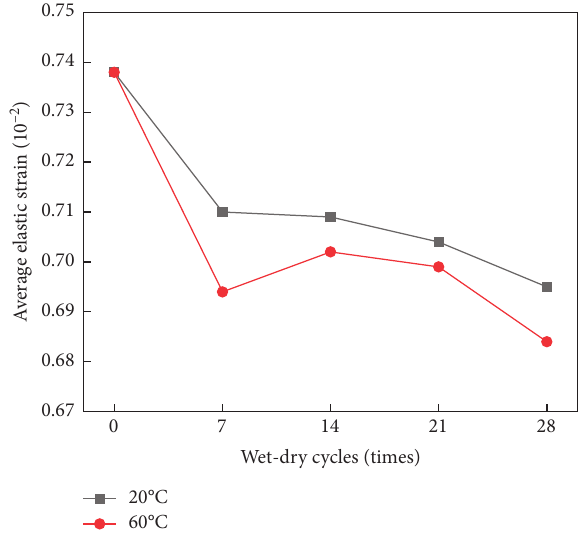
Figure 8: Average elastic strain in 10th–60th loading cycle under different wet-dry